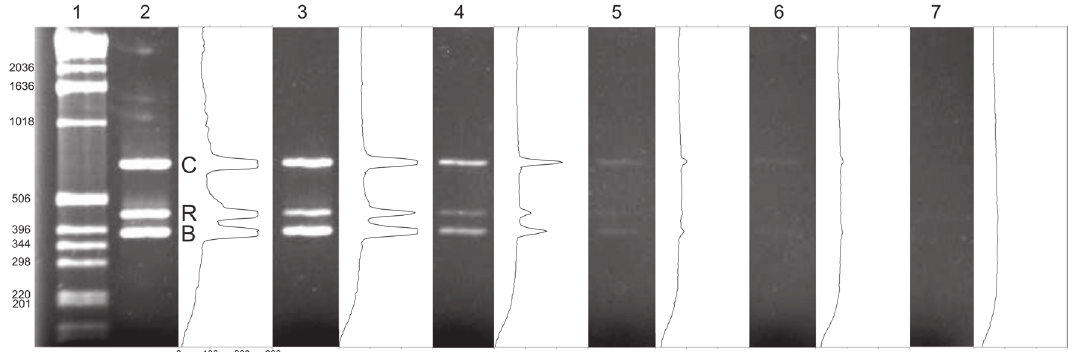
Figure 2. Agarose gel of the Multiplex PCR protocol for detection and identification of species of Crassostrea , native to the Brazilian coast. Each gel lane is paired with their respective optical density analysis. Lane 1: 1 kb ladder. Lanes 1-5 result from sensitivity tests using increasing smaller concentrations of template DNA, i.e. 2 ng/µL, 0.2, 0.02, 0.002, 0.0002. Lane 6: negative control. (C) quality control band (18S rDNA), (R) C. rhizophorae , (B) C. brasiliana , (GL) gross luminance.